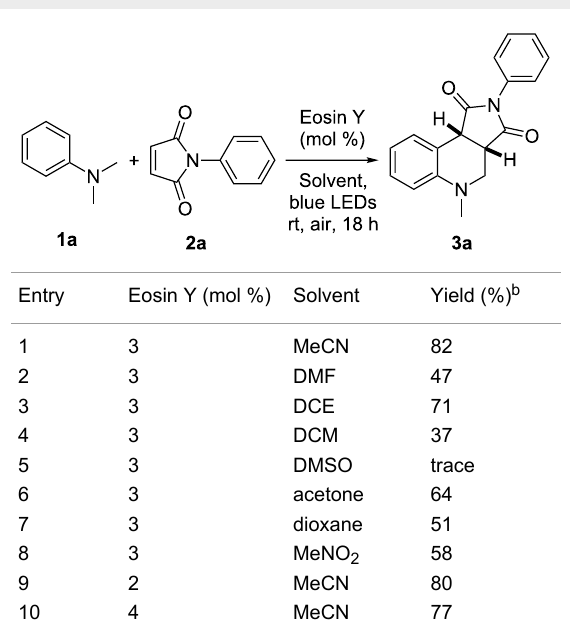
Table 2: Optimization of reaction conditions a